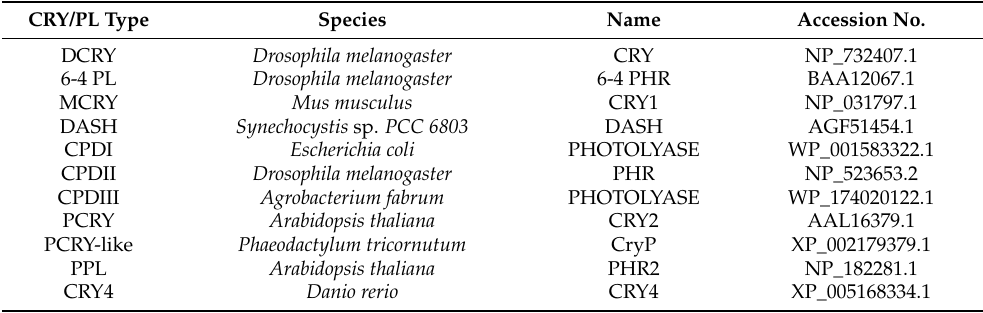
Table 1. Name, accession number, the CRY/PL type, and the species origin of the proteins used as reference for our phylogenetic tree analysis are